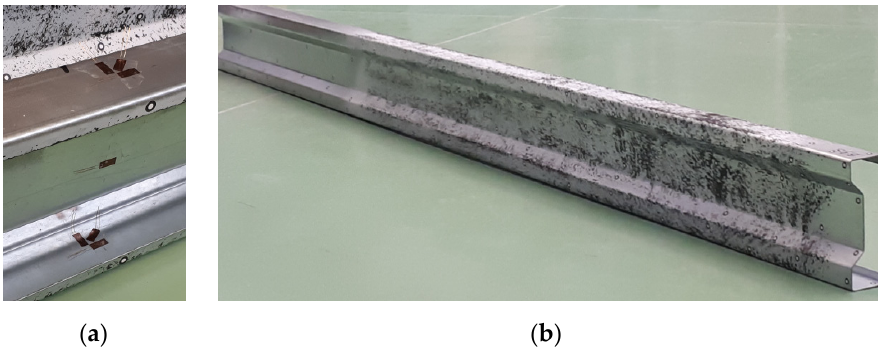
Figure 4. Samples preparation: ( a ) location of Tritop measuring points and electrofusion strain gauges; ( b ) view of samples with matt black and white pattern.